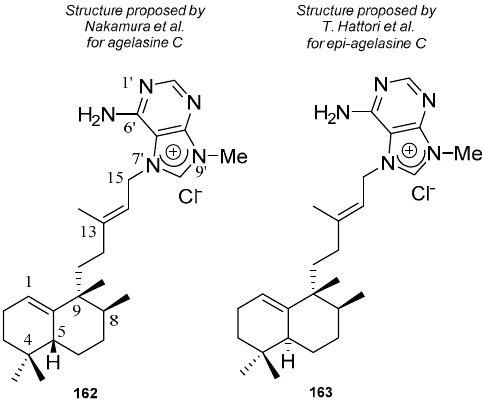
Figure 9. First proposed structures for agelasine C (162) and epi -agelasine C (163).